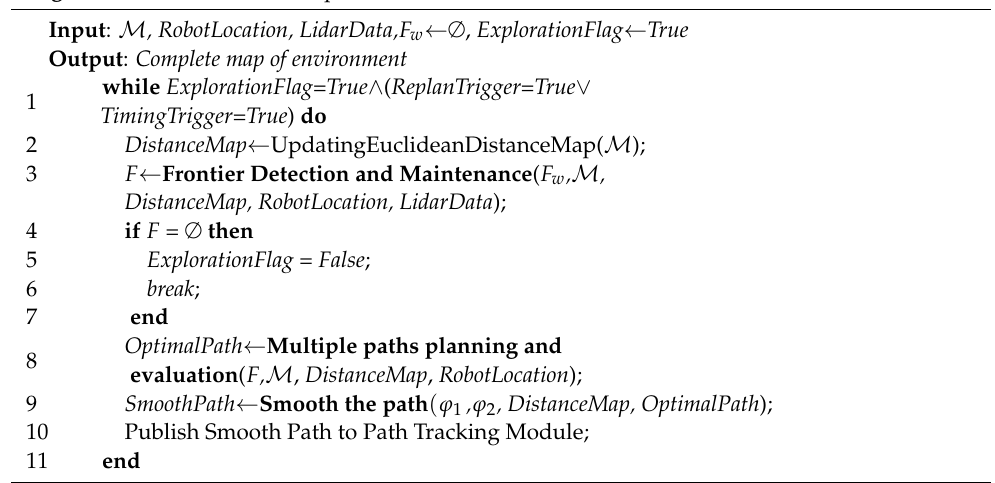
Algorithm 1. Autonomous